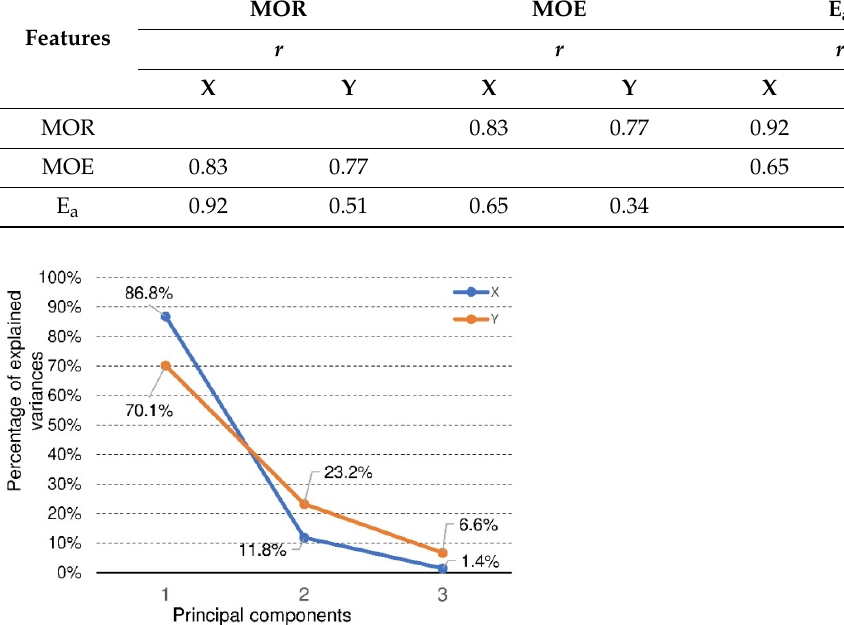
Table 4. The matrix of correlation of features in individual experiments.